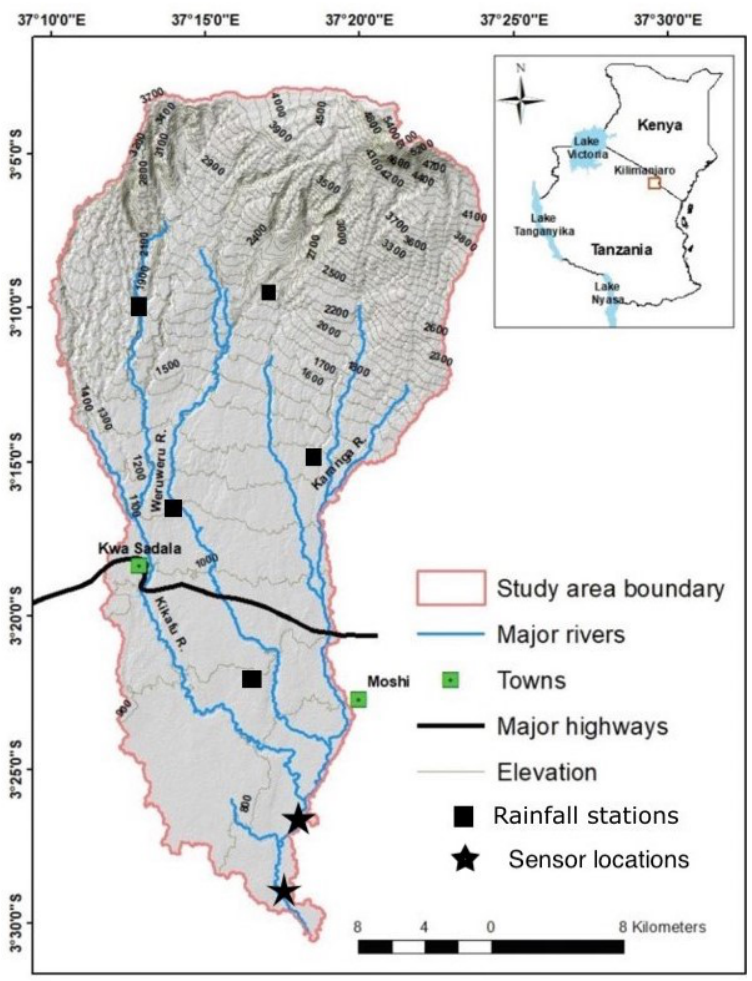
Figure 1. Lower Kikuletwa